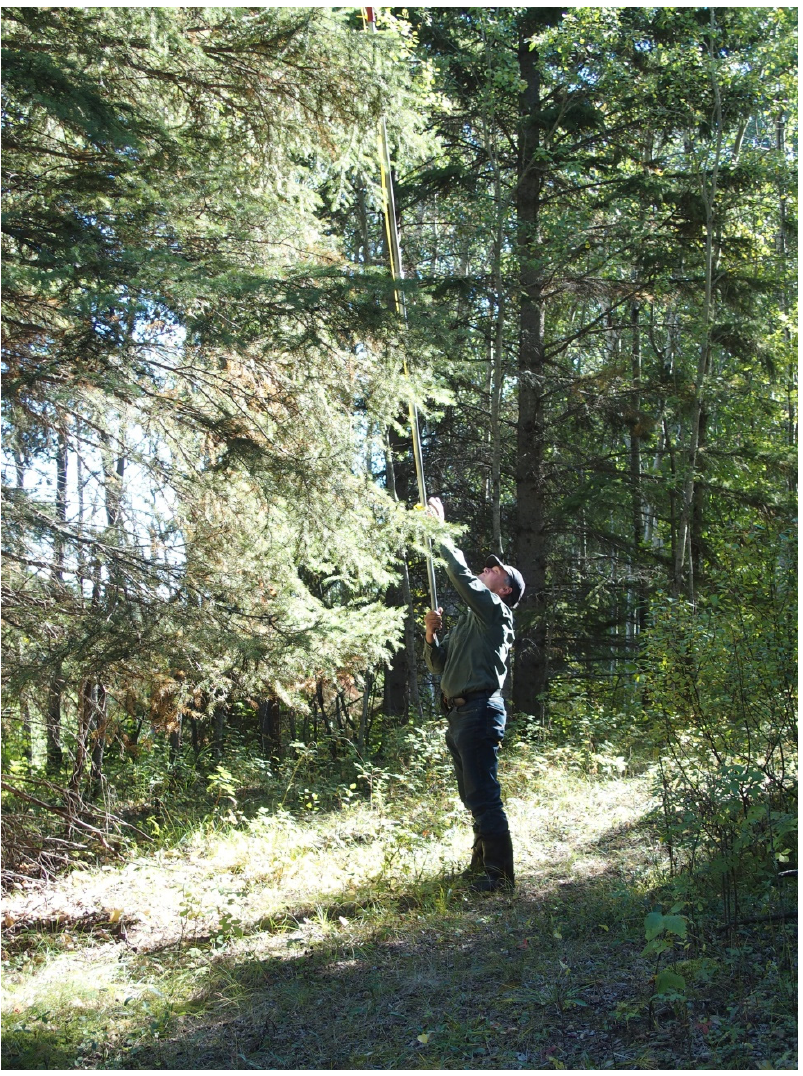
Figure A1. Field sampling. Samples were harvested within lower-one-third outer south-facing part of the crown using a pole pruner.